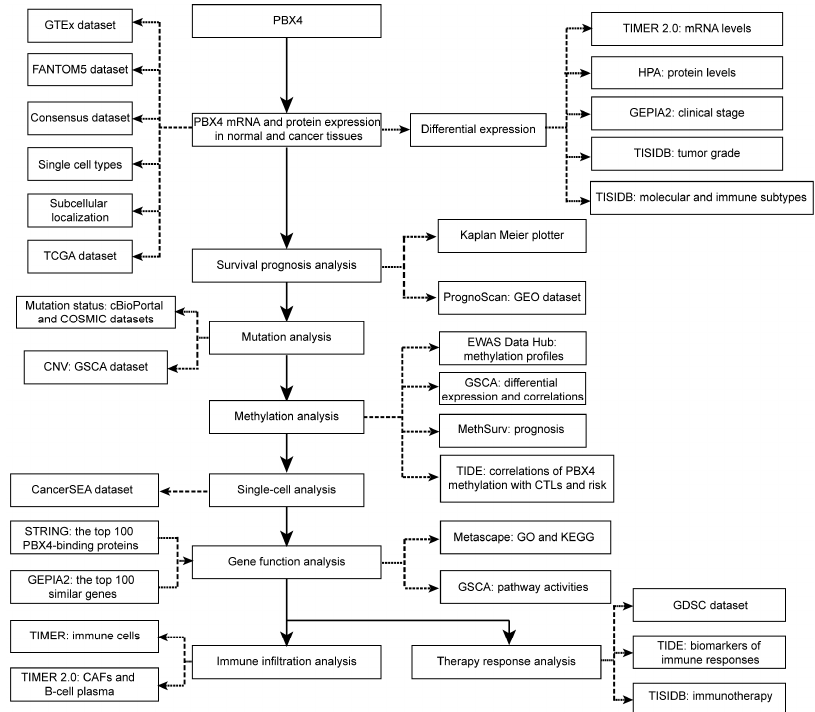
Figure 1. The study design of our